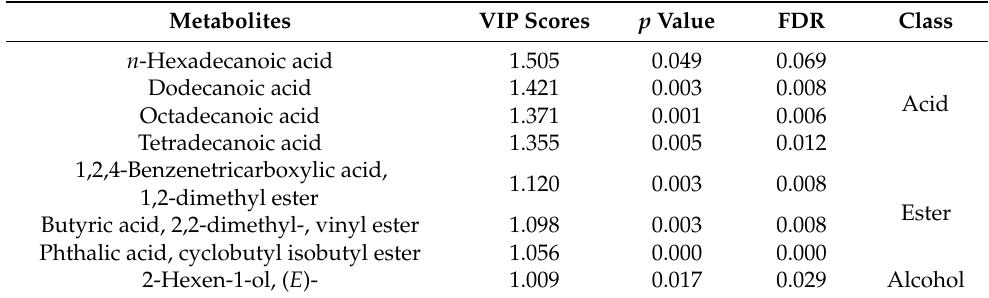
Table 2. Significantly changed metabolites in B. dorsalis larvae exposed to different doses of irradiation treatment.